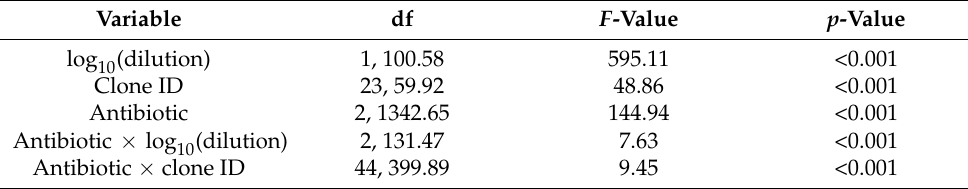
Table 2. Tests of the fixed effects of the model analyzing the